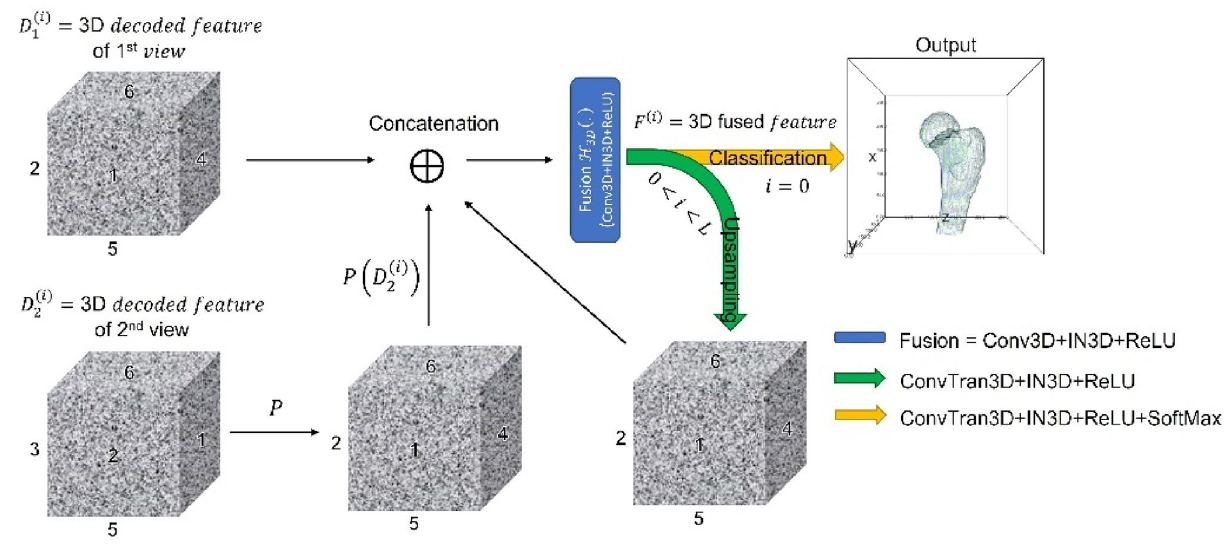
Figure 2. Feature fusion process of biplanar decoded features using convolution over the concatenation of permutation. This diagram explains the fusion process of blue circles in Fig. 1; The symbol ⊕ indicates channel- wise concatenation, and the P indicates permutation of the volumetric